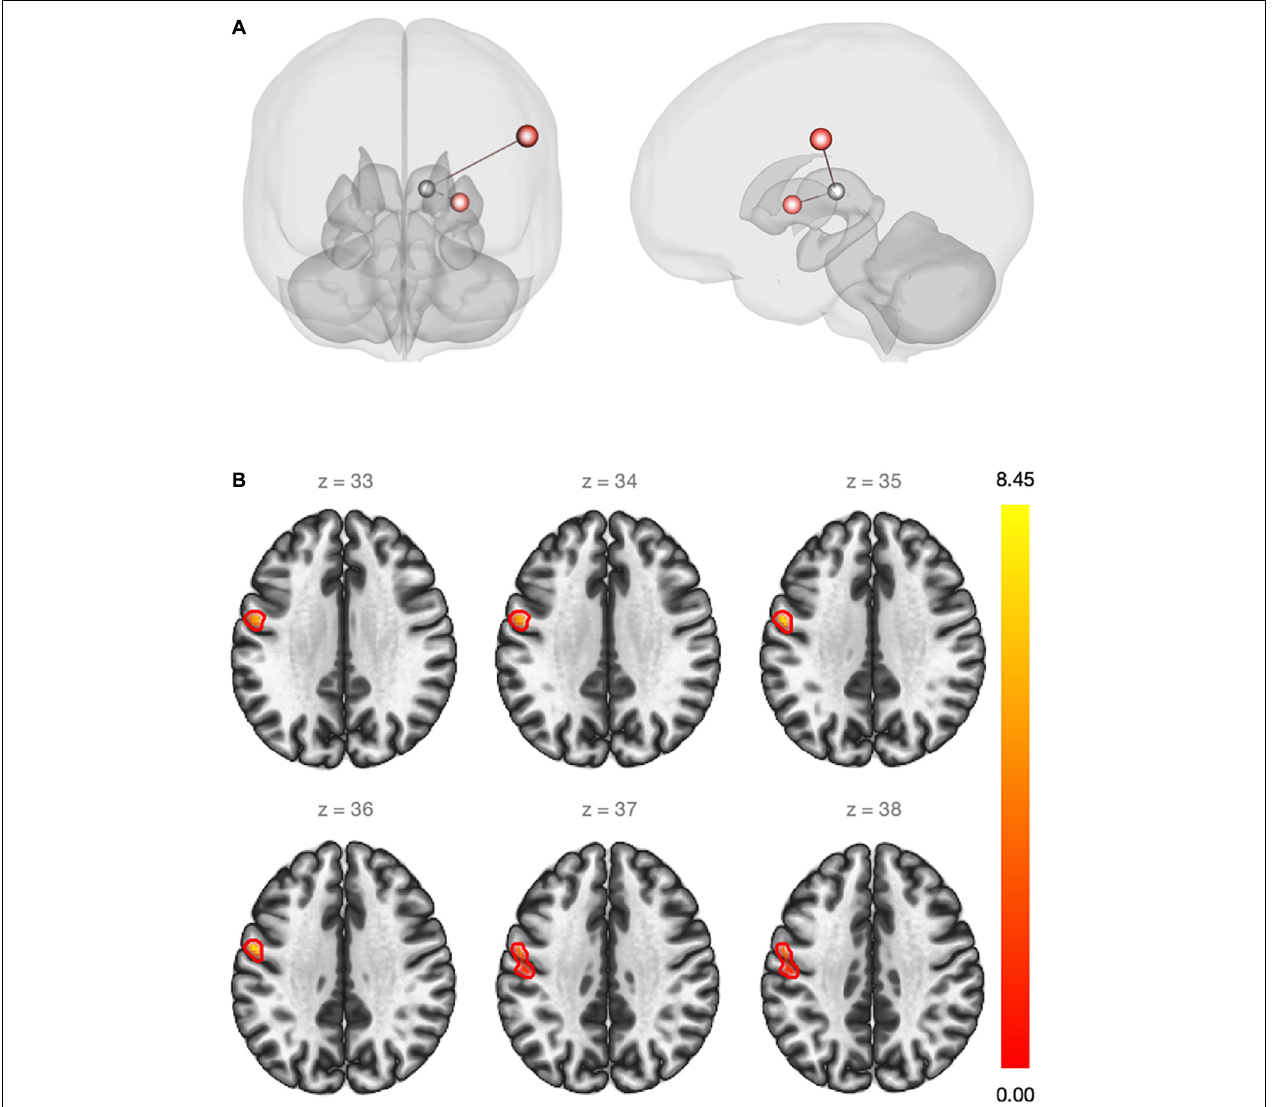
FIGURE 1 | (A) Red regions show an increase in the rs-FC between the left thalamus and the left sensorimotor cortex (beta = 0.20)/left putamen (beta = 0.14) after estradiol therapy (ROI-to-ROI analysis). Statistical significance thresholded at p-FDR < 0.05. (B) Whole-brain seed-to-voxel functional connectivity analysis. Red cluster indicates increased rs-FC between the left thalamus (seed) and voxels of the pre and post-central gyri (beta = 0.21). Cluster size p-FDR < 0.0042. Color bar shows statistical